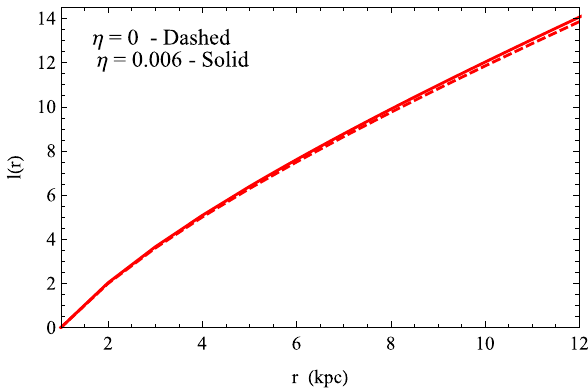
Fig. 14 The diagram of proper radial length l ( r )